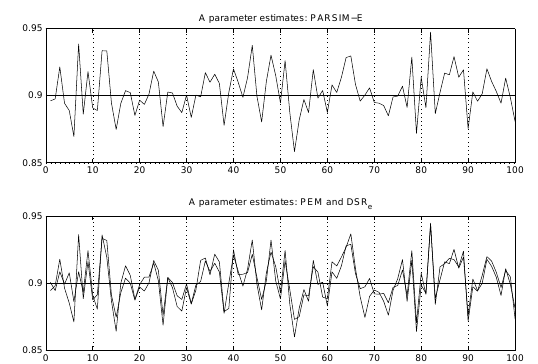
Figure 4: Pole estimates of the closed loop system in Example 7.1 with parameters as in Case 2, and using PARSIM e, PEM and DSR e with, B = 1 . 0 , K = 0 . 5 and E ( e 2 white noise with variance E ( r 2 Figure 1 for a counter example.